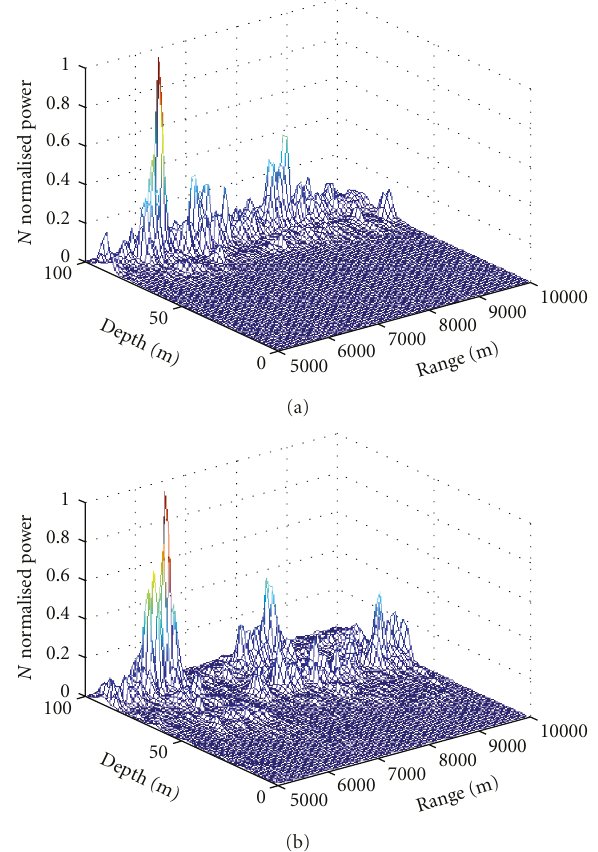
Figure 5: Ambiguity surface for GENLMIS using EMD-MFP localization computationally test case: (a) (SNR = 10dB) and (b) (SNR = − 5